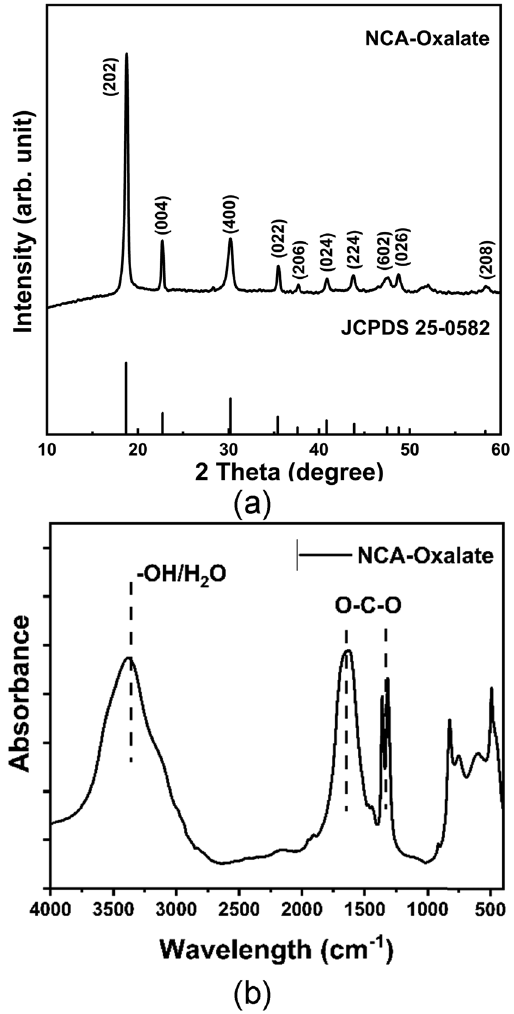
Figure 1: ( a ) X - ray di ff ractogram of NCA - oxalate and ( b ) modi fi ed FTIR spectra of NCA - oxalate.